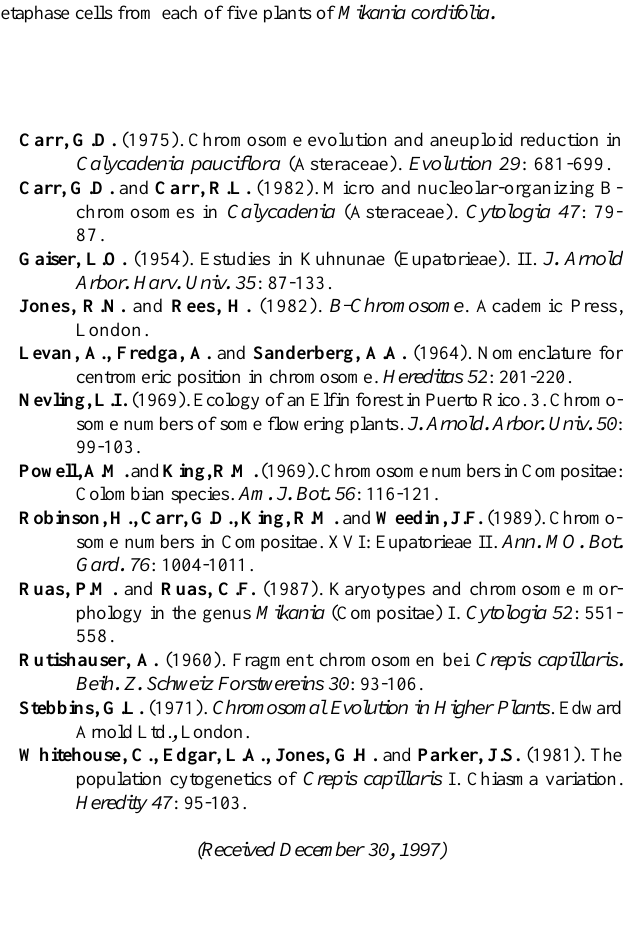
Figure 3 - Distribution of B-chromosome numbers in four metaphase cells from each of five plants of Mikania